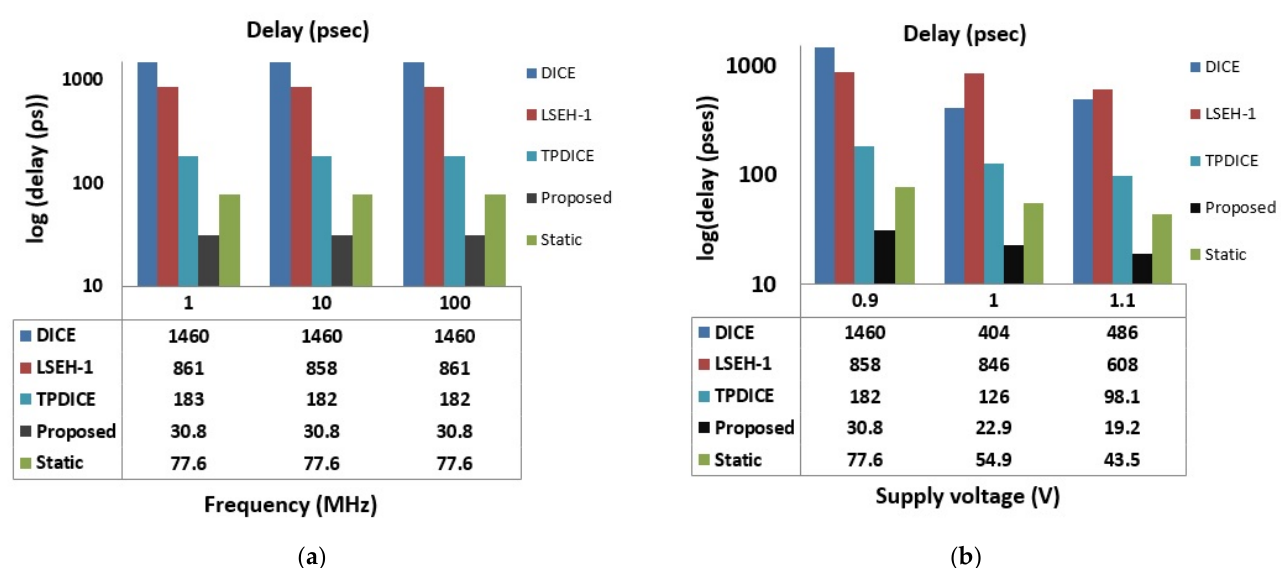
Figure 8. Delay of various D-latches: ( a ) at various frequencies from 1 MHz to 100 MHz and 0.9 V power supply voltage;